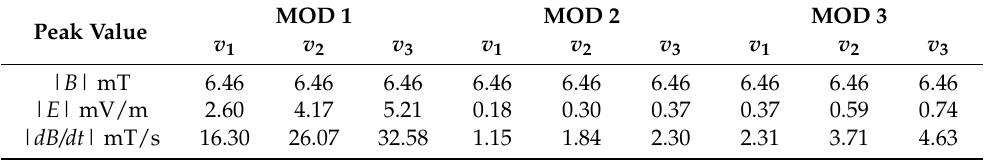
Table 5. Peak values of the calculated exposure parameters for z = 160 cm (head in standing position). Peak